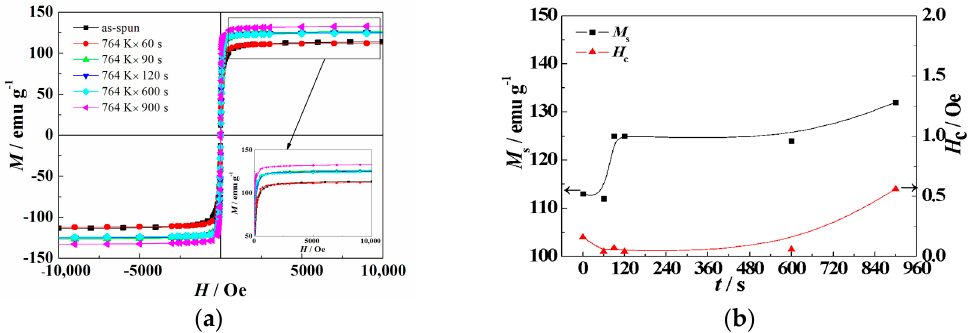
Figure 7. Magnetization hysteresis curves taken from the (Fe 0.4 Co 0.6 ) 79 Nb 3 B 18 alloys annealed at 764 K ( a ) and the variation of M s and H c as a function of incubation time t ( b ).